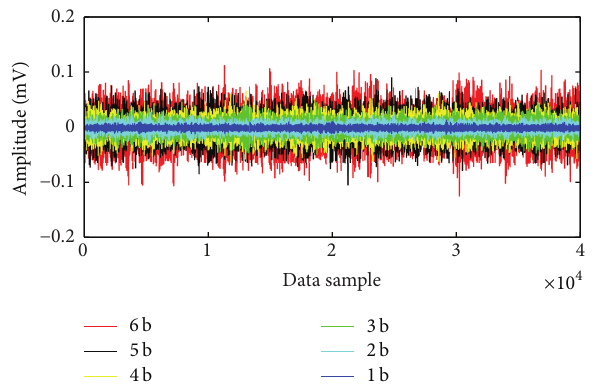
Figure 8: Raw AE signal due to VL through notched exhaust valve in cylinder 3.